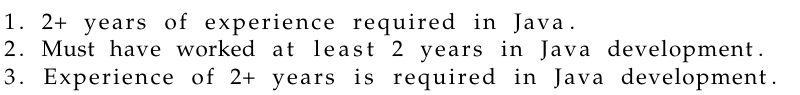
Table 3. Sample text to show the wording variation in a job